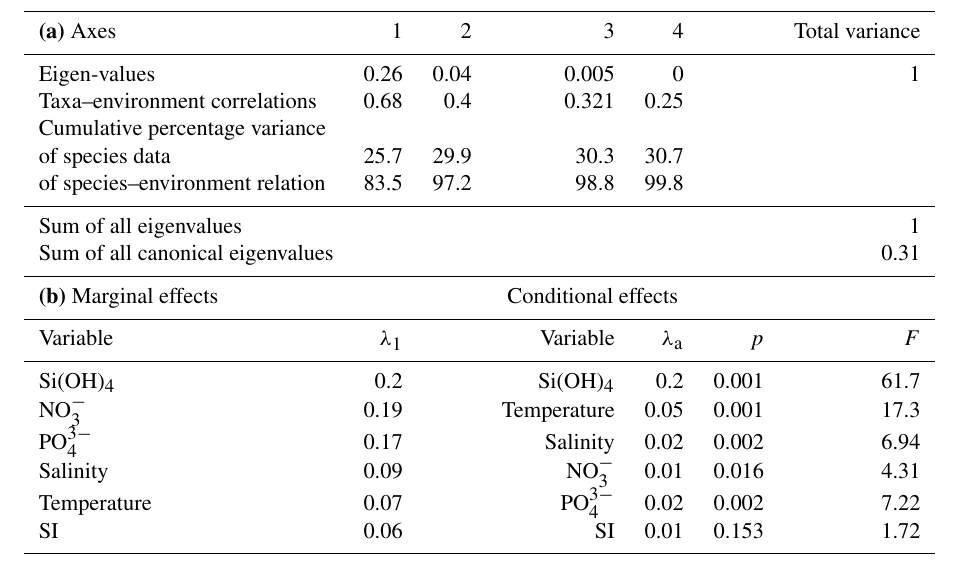
Table 4. Results of the redundancy analyses (RDA) with the eigen-values, taxa–environmental correlations and percentages of variance explained used in the analysis (a) . Automatic forward selection (a posteriori analysis) was used to determine the environmental variable(s) that best explain the variance of the data (b) . The subset of environmental variable(s) that significantly explained phytoplankton distribution are referred to as marginal effects ( λ 1 ) when analysed individually, or conditional effects ( λ a ) when analysed additively in the model (b) . Explanatory variables are temperature ( ◦ C), salinity, nitrate (NO − ; µmolL − 1 ) , phosphate (PO 3 − ; µmolL − 1 ) , silicate (Si(OH) 4 ; µmolL − 1 ) , 3 4 and stratification index (SI) (kgm − 4 ) . Significant p values ( p < 0.05) represents the variables that explain the variation in the